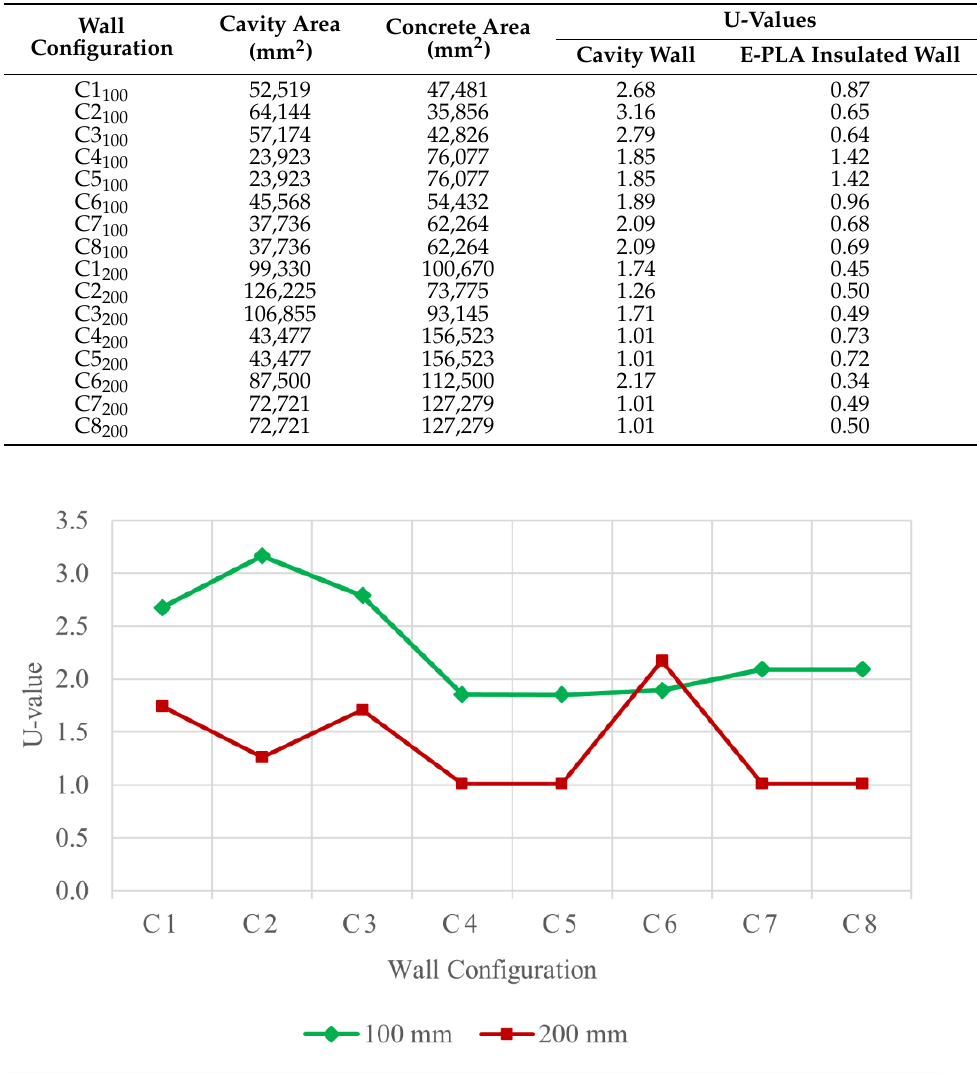
Figure 6. The U -value results obtained for different wall configurations with different wall thickness. Table 6. The U -value reduction percentages.